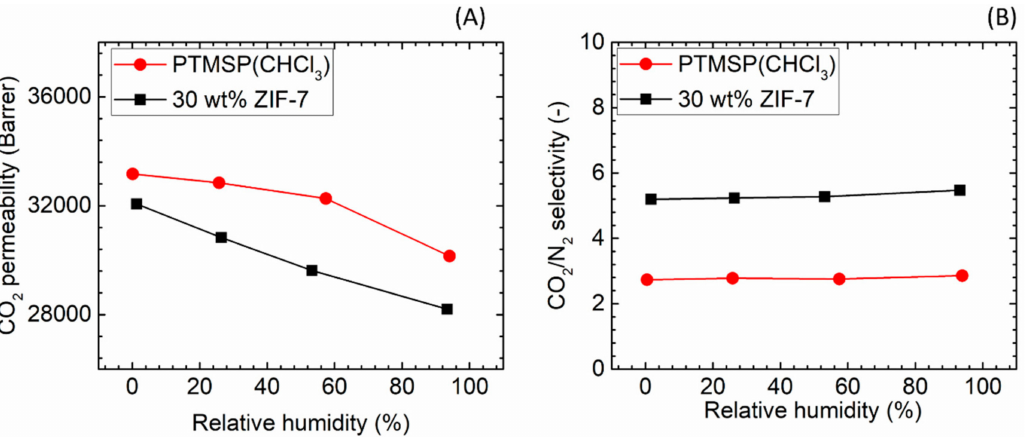
Figure 13. Gas separation performances of PTMSP/ZIF-7 hybrid membranes. ( A ) CO 2 permeability and ( B ) CO 2 /N 2